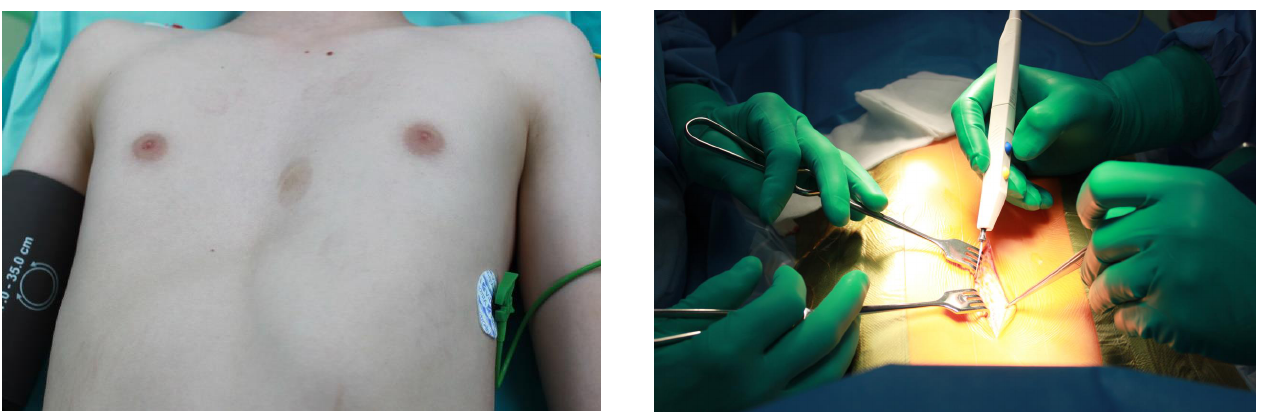
Table 1. Photos of the